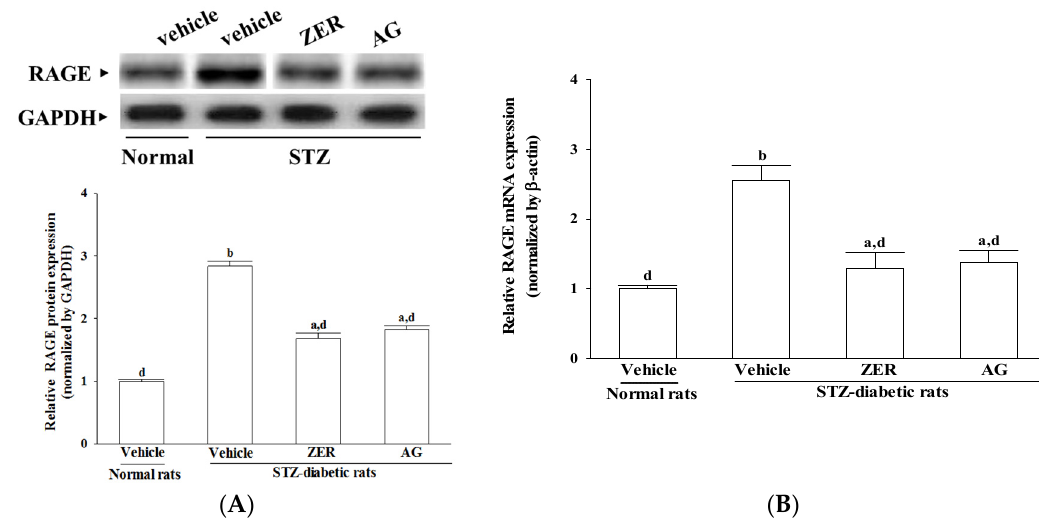
Figure 2. Effects of the treatments on the ( A ) protein and ( B ) mRNA levels of receptors for advanced glycosylated end products (RAGE) in retina of rats. STZ ‐ diabetic rats were administered 40 mg/kg/day ZER, or 50 mg/kg AG by oral gavage once daily for three months. Another group of STZ ‐ diabetic rats and normal rats were administered the same volume of vehicle used to prepare the test medication solutions. Data are mean ± SEM from eight rats per group, and the experiments were repeated independently at least three times with similar results. a p < 0.05 and b p < 0.01 compared to vehicle ‐ treated normal rats, respectively; c p < 0.05 and d p < 0.01 compared to the values of vehicle ‐ treated STZ ‐ diabetic rats, respectively.